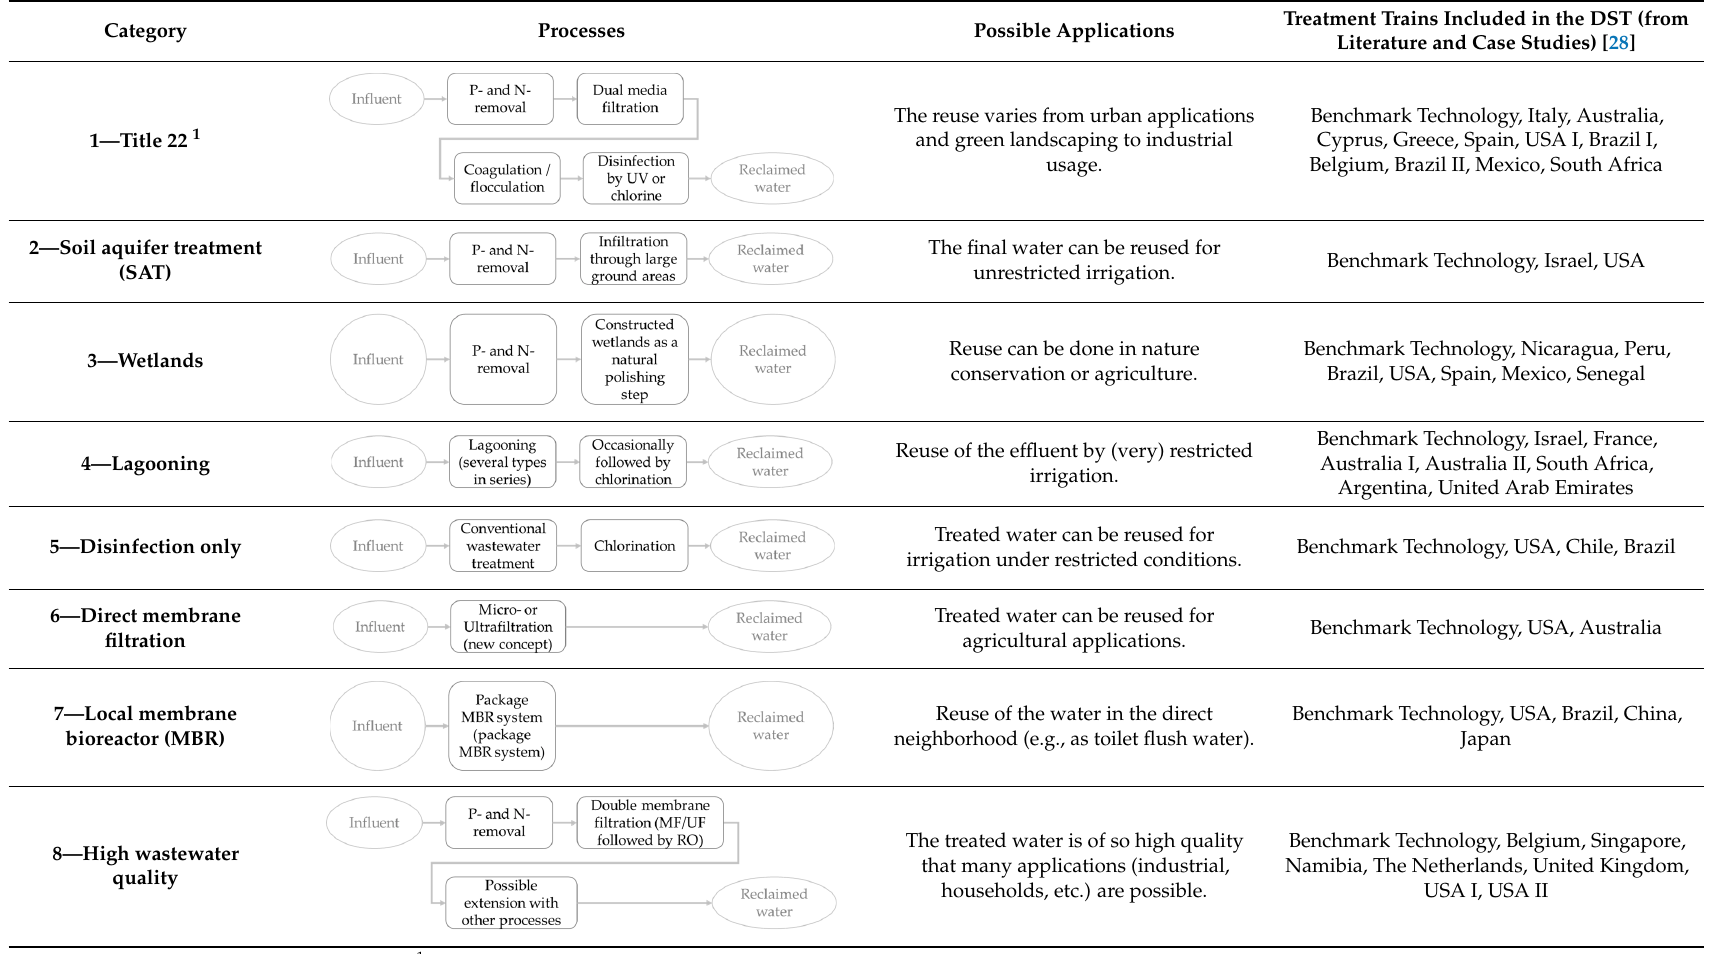
Table 3. Treatment train (TT) categories, description, and list of treatment trains included in the DST [28] .